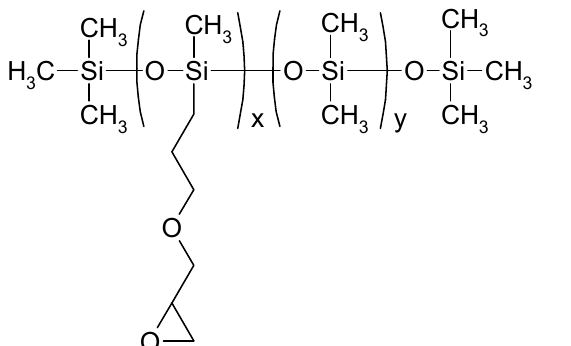
Figure 1. Chemical structure of the siloxane.